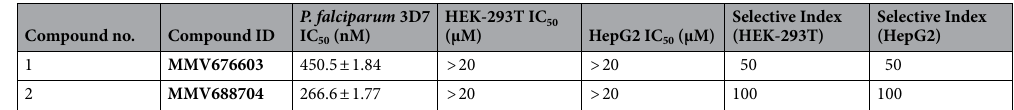
Table 2. In-vitro activity of the two hits identified from Pathogen Box against parasite and mammalian cell culture.